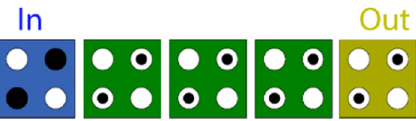
Figure 4: Cell con fi gurations of QCA binary wire.